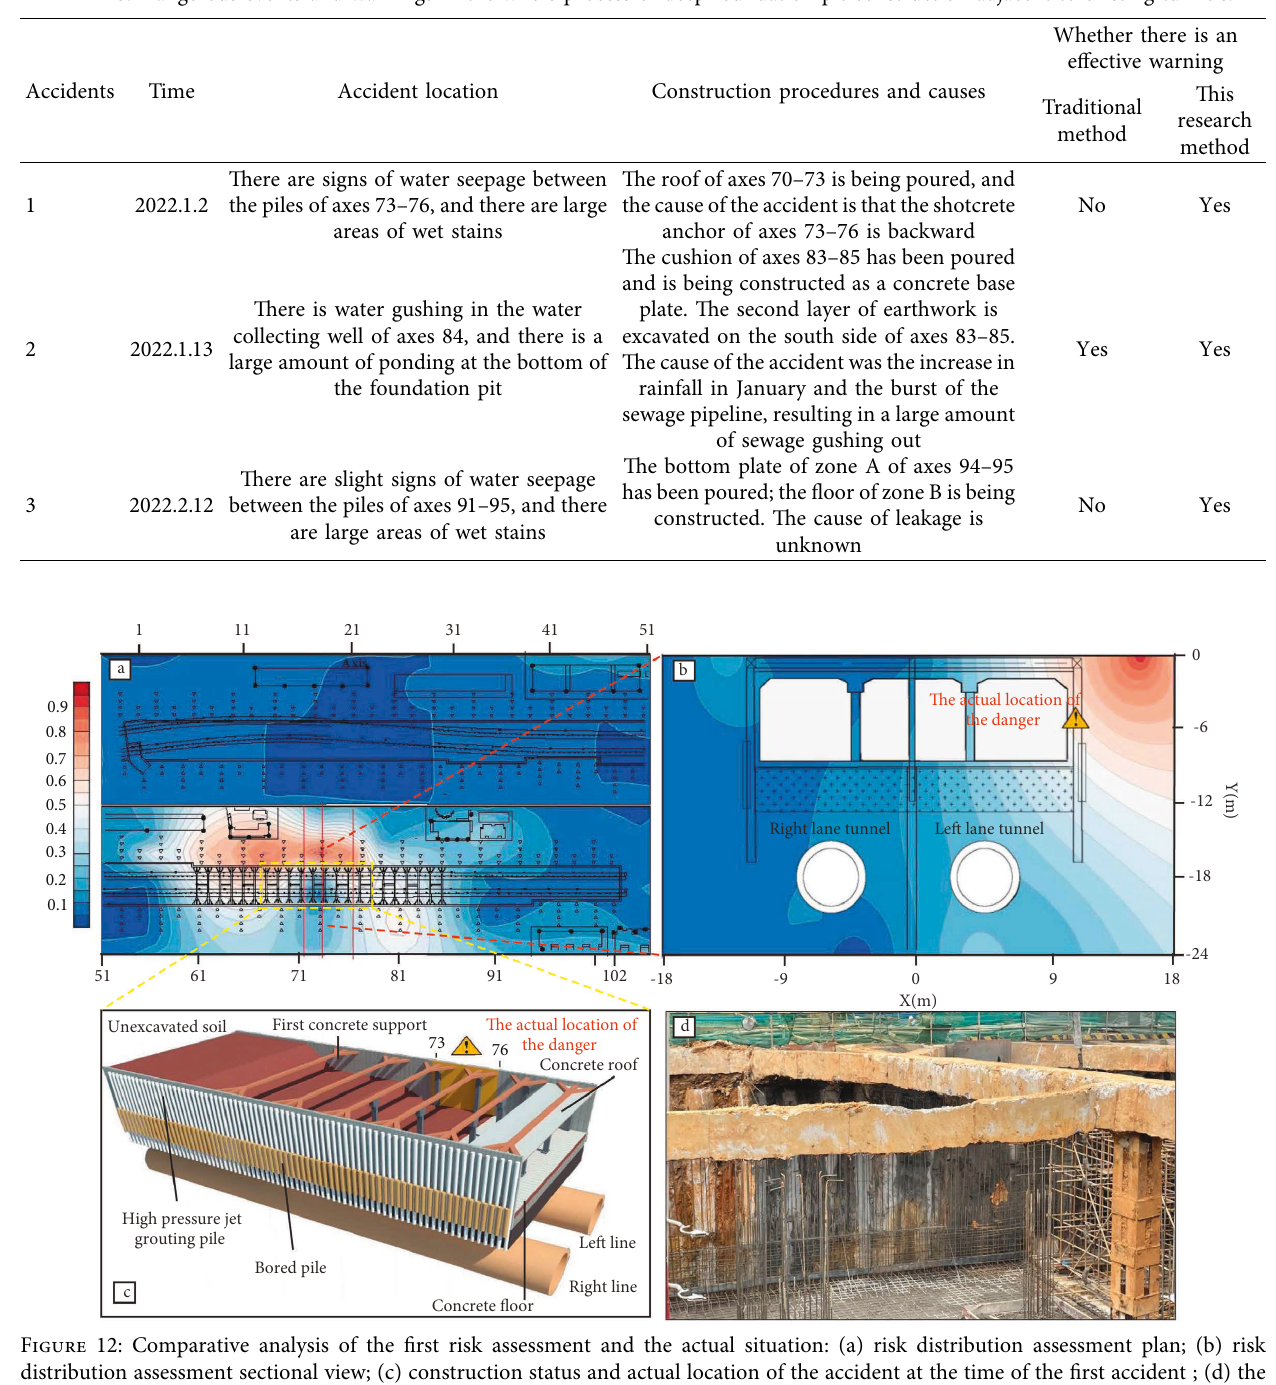
Table 8: Dangerous events and warnings in the whole process of deep foundation pit construction adjacent to existing tunnels.